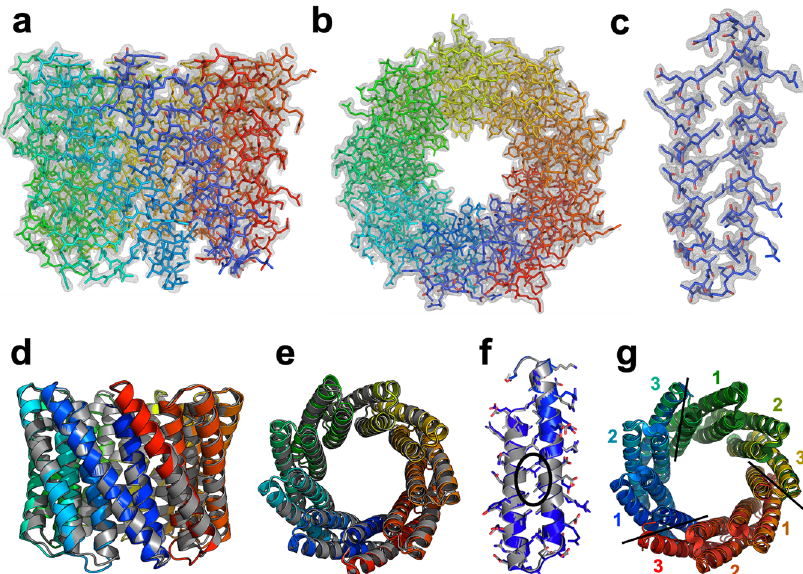
Fig. 4 Crystal structures of tcTRP9 and tcTRP9 3 . a – c Re fi ned models and corresponding 2Fo-Fc electron density map for full-length monomeric tcTRP9. c Illustrates the map and re fi ned model for a single repeat within the construct. The structure was determined at 2.1 Å resolution. d – f Superposition of the designed model of tcTRP9 (gray) and the experimental crystallographic structure of the same construct (rainbow spectrum; N-terminal repeat = blue, C-terminal repeat = red). The alpha-carbon rmsd between the design and the re fi ned crystallographic coordinates is 0.5 Å. The circled residues in f (which shows the side chains for repeat #1 from the design and from the crystal structure) are L11 and L37, which pack against one another in both models, but display opposing rotameric conformations that each promote their interaction in the interhelical interface of the repeat. g Superposition of the crystal structure of the monomeric tcTRP9 construct (from the earlier panels) and the crystal structure tcTRP9 3 homotrimer (a self-assembling particle-containing three subunits, each of which contains 3 repeats of the same sequence as shown in Fig. 1; the structure was solved at 3.2 Å resolution). The structure of the latter construct con fi rms its homotrimeric assembly (as previously indicated by size exclusion chromatography analysis) and alpha-carbon rmsd between superimposed monomer and homotrimer of 0.5 Å. The repeat numbering (1 − 3, repeated three times) and lines illustrate the subunit boundaries and locations for the homotrimeric tcTRP9 3